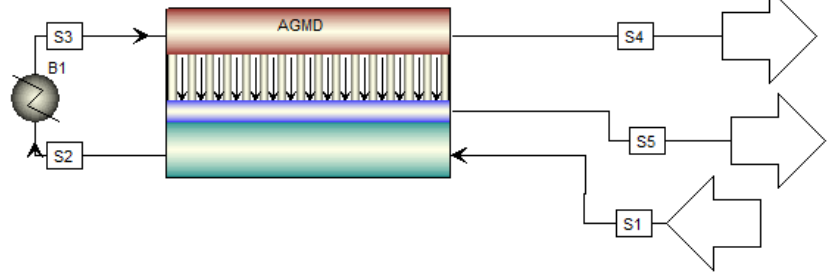
Figure B3. Flowchart of a base case AGMD-based desalination process.